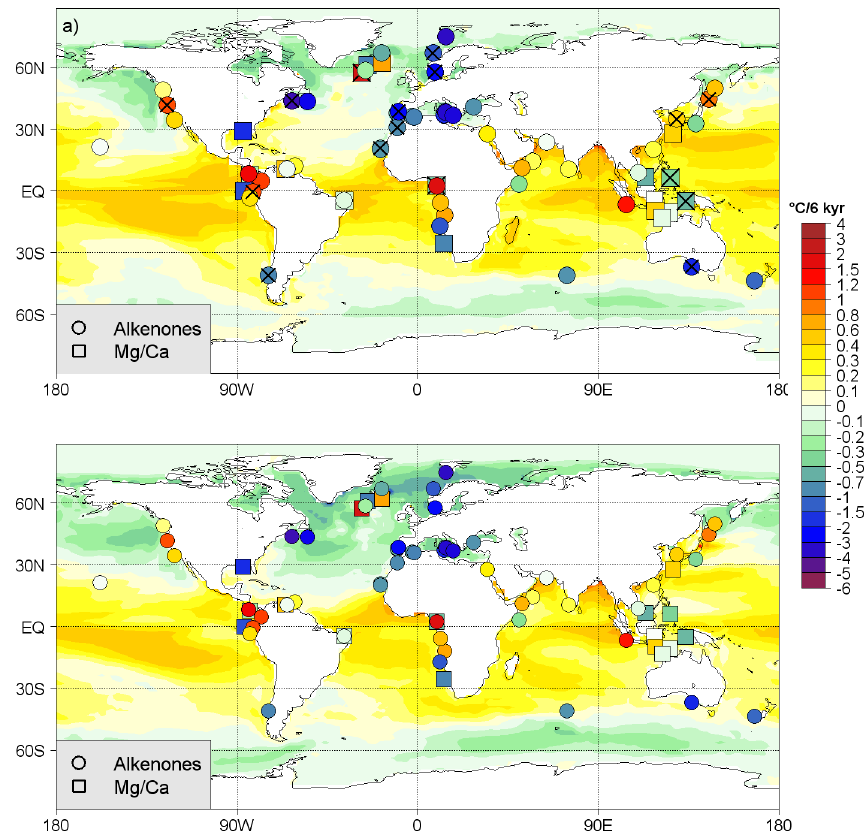
1895 Figure 9 Fig. 9. Global reconstructed SST trends compared to simulated annual mean SST anomalies as calculated from the ensemble median mean of the models listed in PMIP2 (a) and PMIP3 (b) . Crosses in (a) indicate the record locations where the test of the regression residuals fails to show